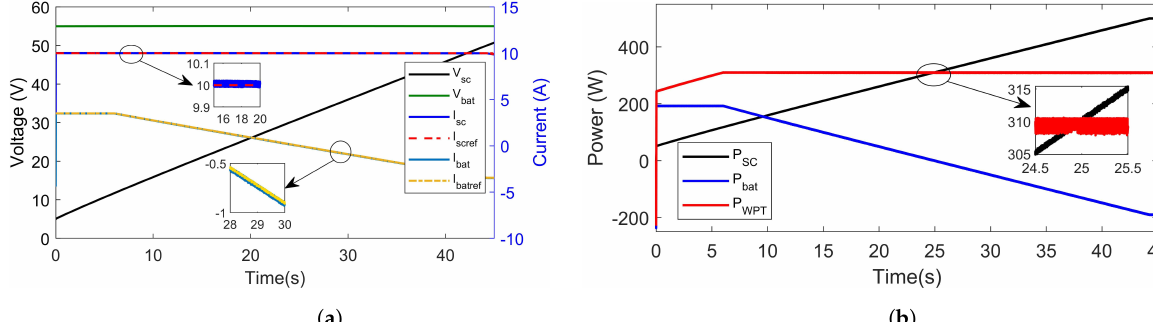
Figure 10. For V sci = 5 V ( a ) V sc , I sc , V bat , I bat , ( b ) P sc , P bat , P wpt .